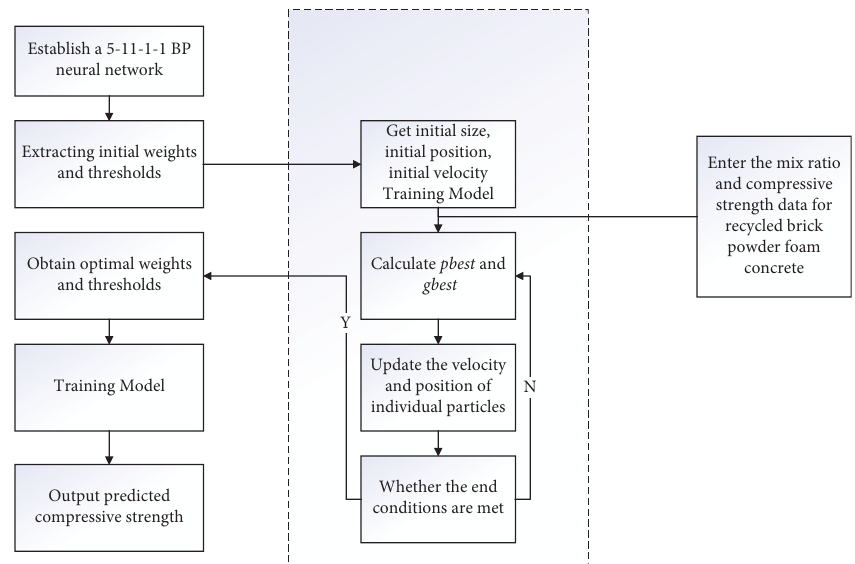
Figure 10: Establishment process of PSO-BP neural network.